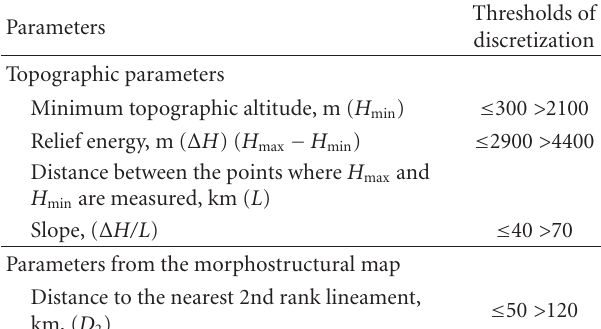
Table 2: Characteristic D -features and N -features of nodes for